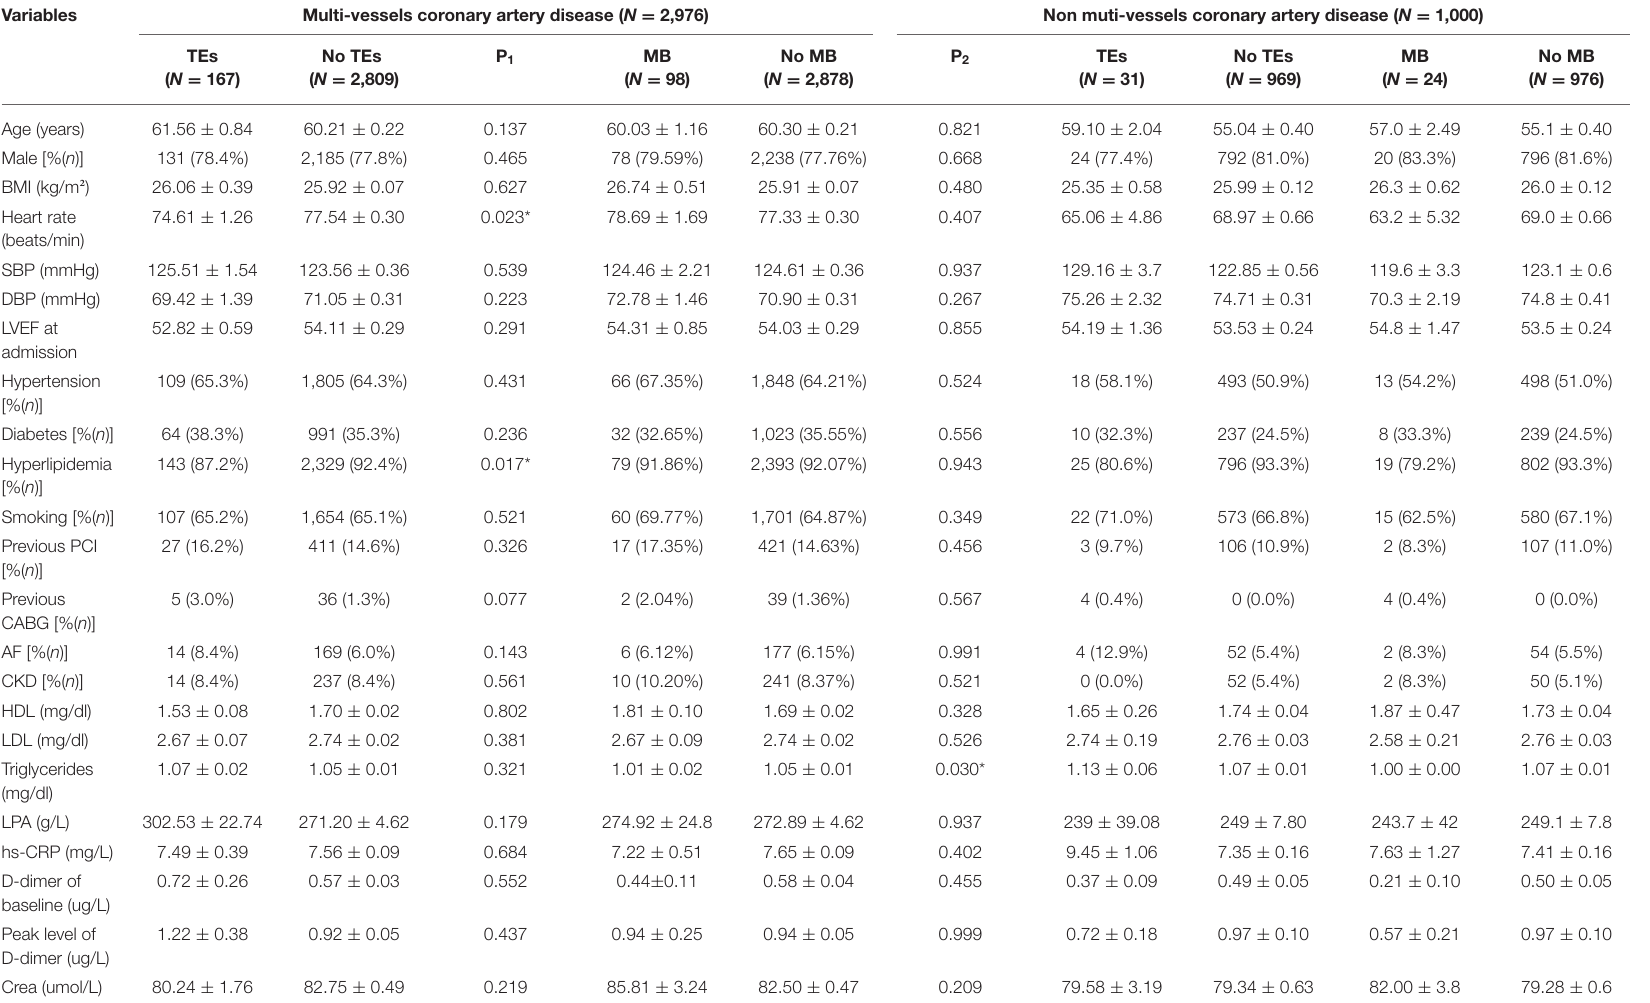
TABLE 1.1 | Baseline clinical characteristics of patients with vs. without thrombotic events or major bleeding events.